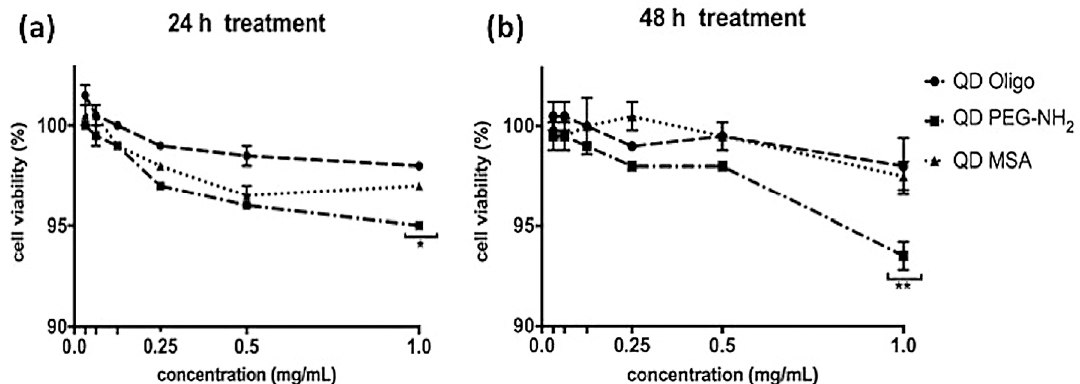
Figure 2. In vitro cytotoxicity of RAW 264.7 macrophage cells treated with QDs with different surface chemistries (Oligo, PEG-NH 2 , and MSA). The graph represents cell viability at ( a ) 24 h and ( b ) 48 h, determined by Alamar Blue assay. Data represents mean standard error of the mean ( n = 3; * ( p < 0.05), and ** ( p < 0.01); one-way ANOVA).